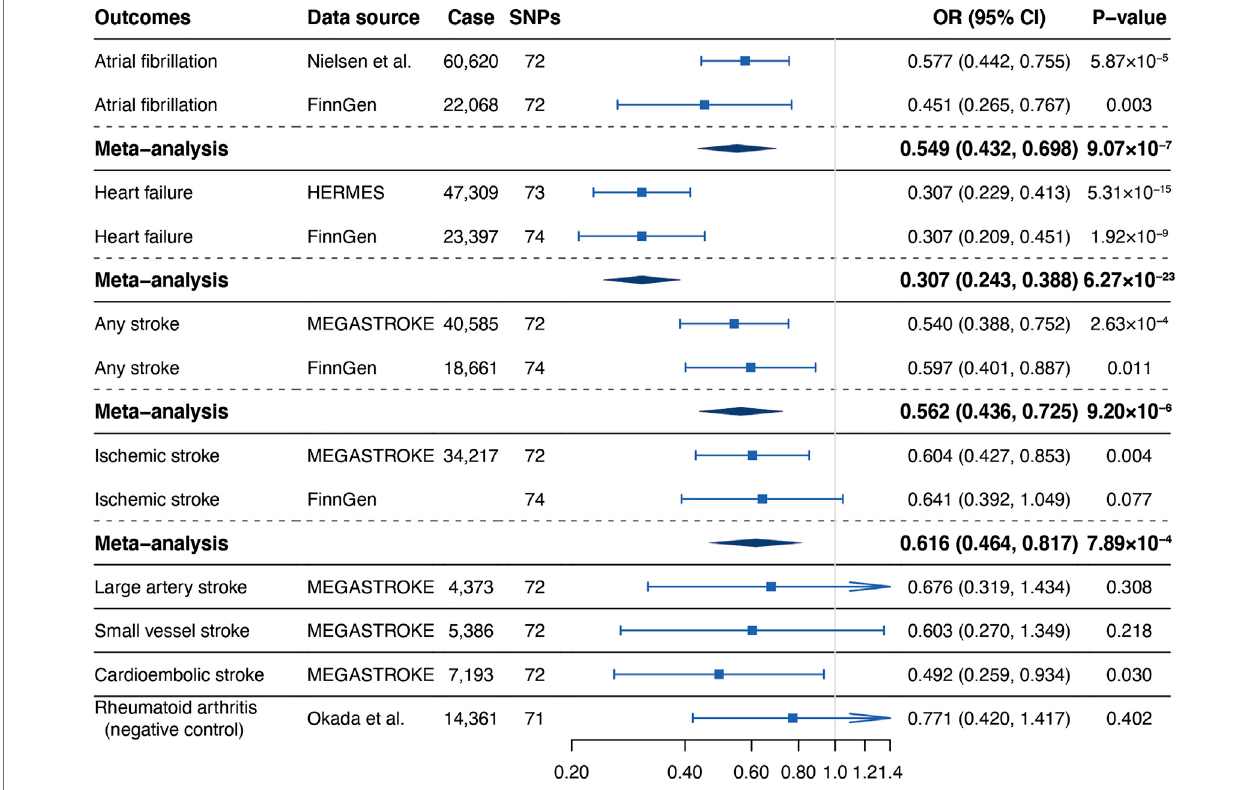
Frontiers in Genetics |